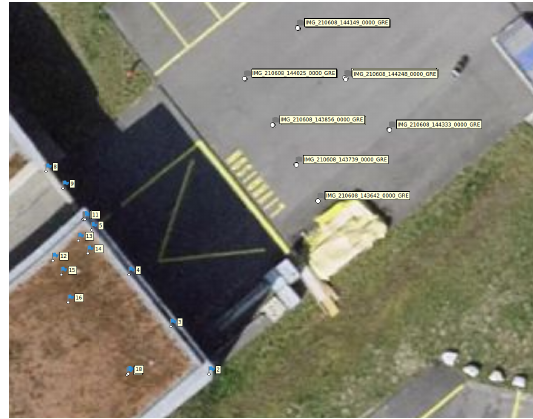
Figure 3: Calibration site at the HEIG-VD composed of 18